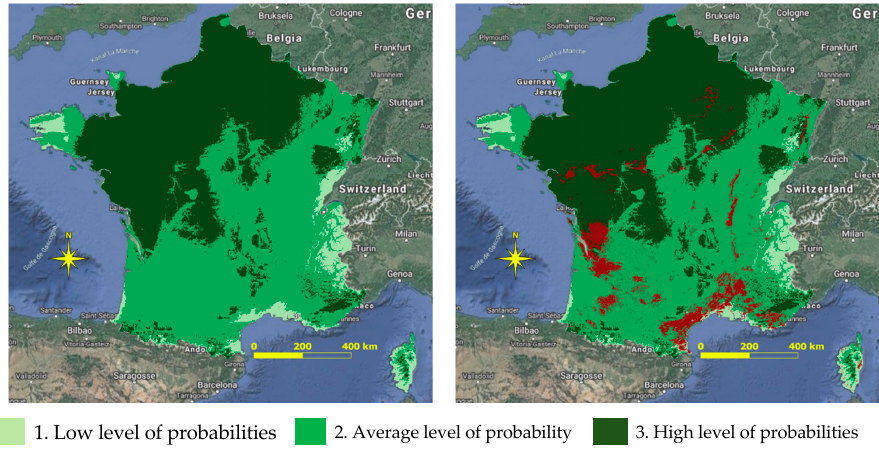
Figure 6. Potential suitable areas for grapevine crop according to RCP 4.5 climate scenario for 2050. Grapevine crops declared in 2018 are represented in red.